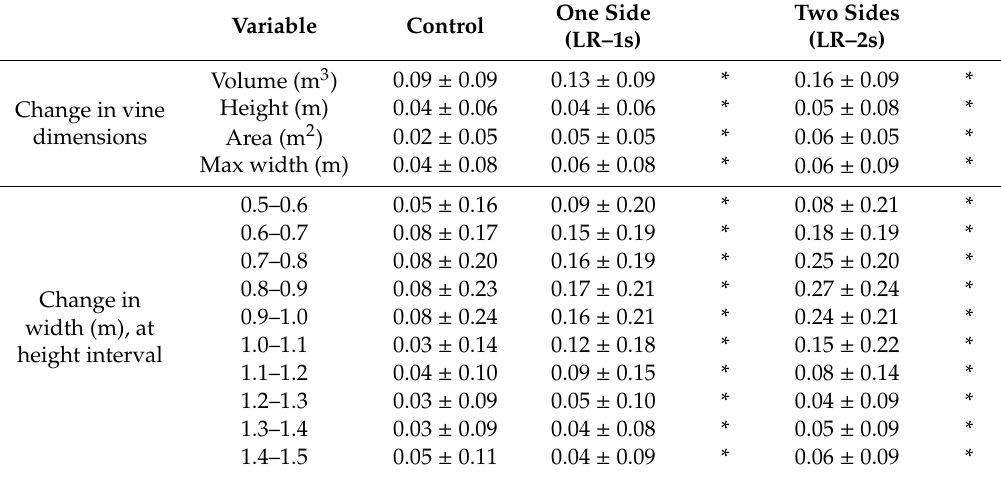
Table 4. Mean and standard deviation of vine dimensions change after the leaf removal experiment at Traibuenas vineyard. The table is divided in two parts: (1) changes in main dimensions of the vine, (2) changes in the width at di ff erent height intervals. Values followed by an asterisk are indicative of significant di ff erences among the vine dimensions before and after the canopy management (paired T -test at p =